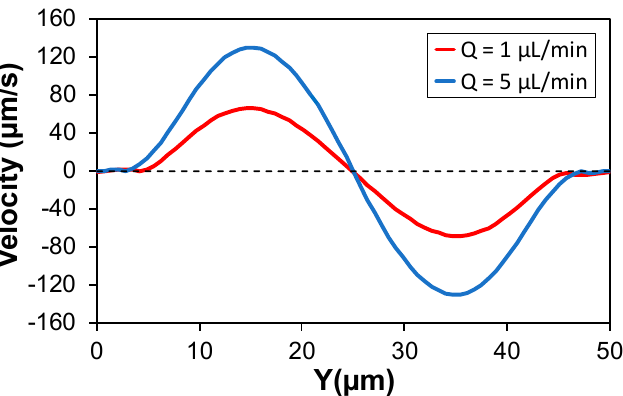
Figure 6. Effects of flowrate on the magnitude of N 2 -induced secondary flow orthogonal to the main flow direction along the channel horizontal centerline. Magnitude of the secondary flow is almost doubled when increasing the flowrate from 1 µ L/min ( Wi = 3.6) to 5 µ L/min ( Wi = 18) at constant α =